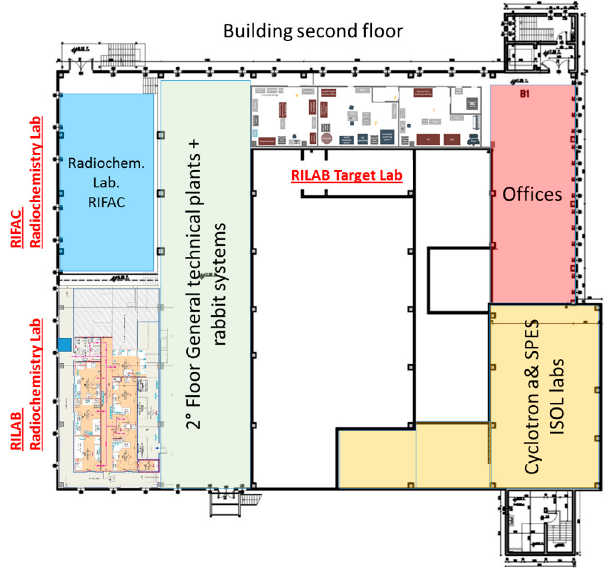
Figure 4. The layout of the LARAMED laboratories at the second floor of the SPES building.